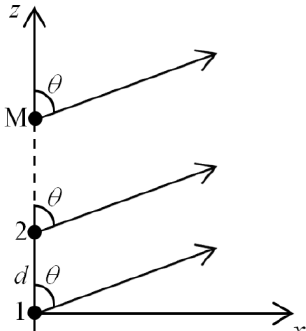
Figure 4. Linear array of M isotropic